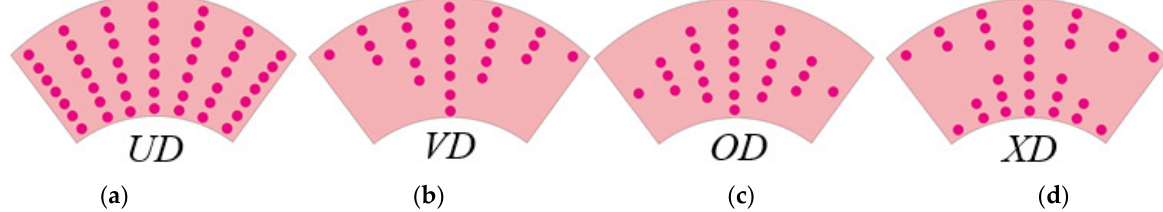
Figure 2. Cross-section of shallow shells with uniform and linearly patterned CNTs ( a ) UD, ( b ) VD, ( c ) OD and ( d ) XD.